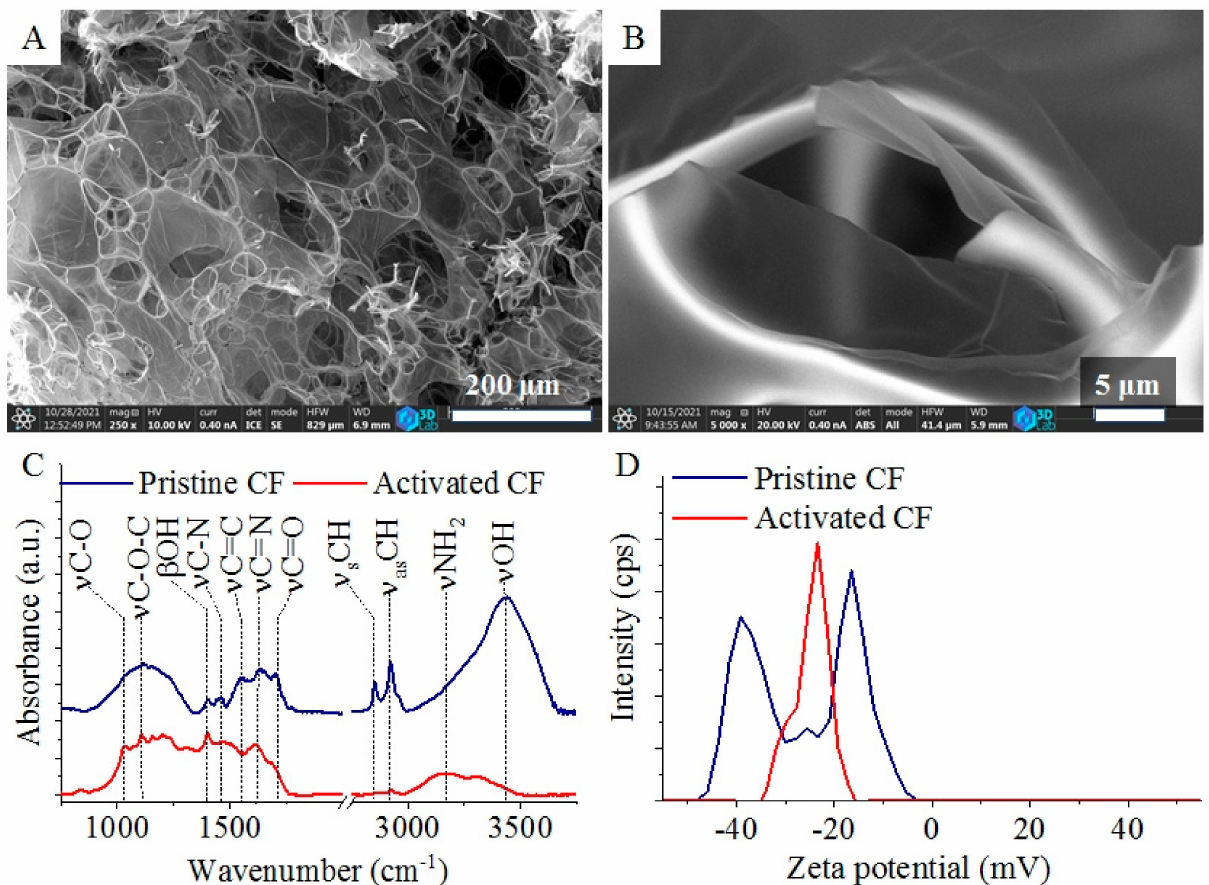
Figure 1. SEM images of the carbon foam ( A ) and its carbon foil ( B ). FTIR spectra ( C ) and zeta potential distributions ( D ) of pristine and activated carbon foils